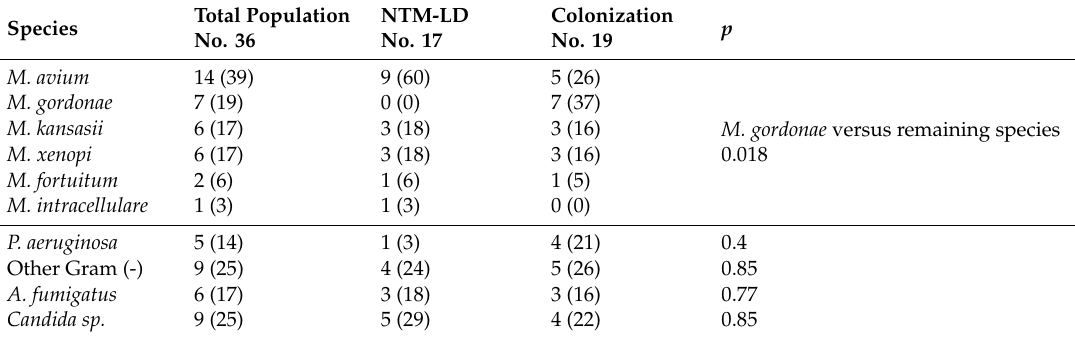
Table 3. Results of microbiological examination in 36 patients with obstructive lung diseases.